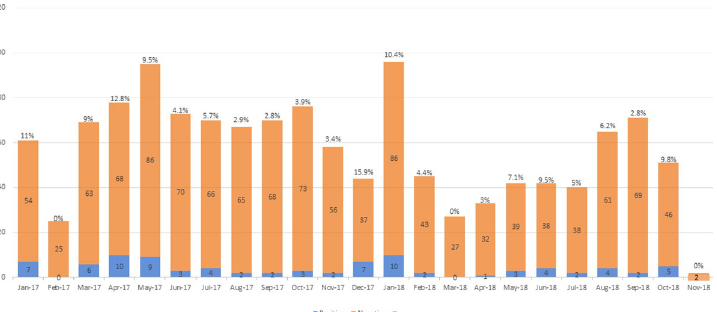
Fig 2. Seasonal trend of leptospiral IgM positivity rate within the DR. Congo national network for yellow fever surveillance (2017–2018). Blue and Orange charts indicate the number of positive leptospiral IgM cases and the number of specimens tested. The percentage on top of each chart indicate the positivity rate for leptospiral IgM of the month.